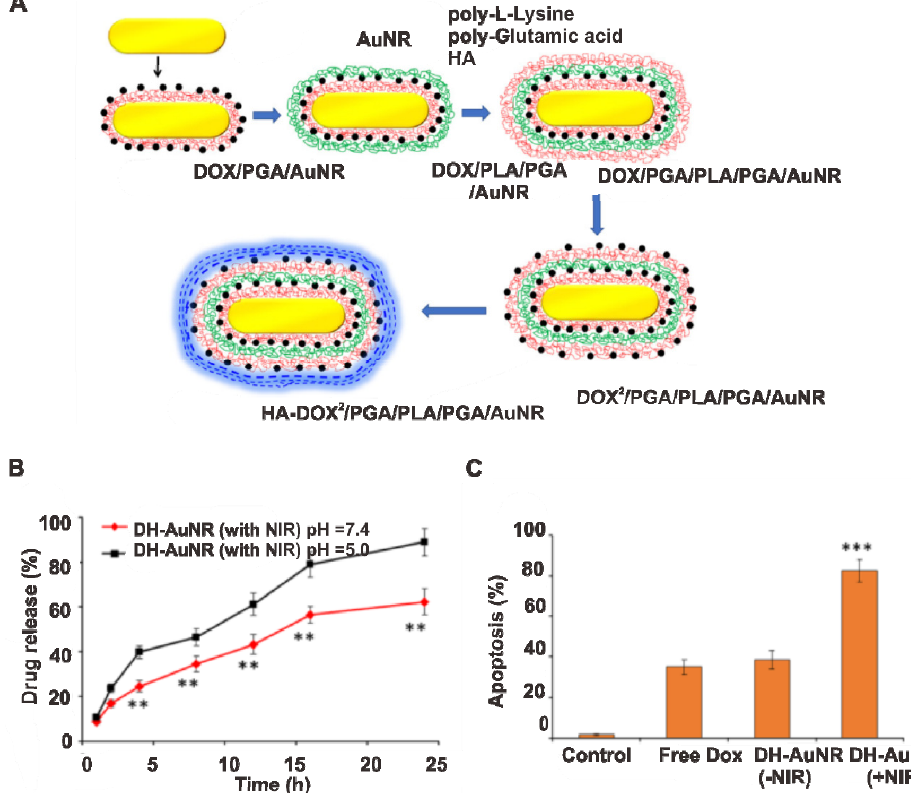
Figure 6. Polymer-AuNPs for use in PDT. ( A ) The schematic diagram for the layer-by-layer polyaminoacid coating on AuNR. ( B ) DOX release from the nanocomposite under different physiological pH, using NIR trigger. ( C ) Apoptosis analysis of SKOV3 cells after staining with Annexin-V and PI using flow cytometer and the results are represented as a bar diagram. and ** p < 0.001. *** p < 0.001. Adapted with permission from [125]. Portland Press Ltd., 2019.